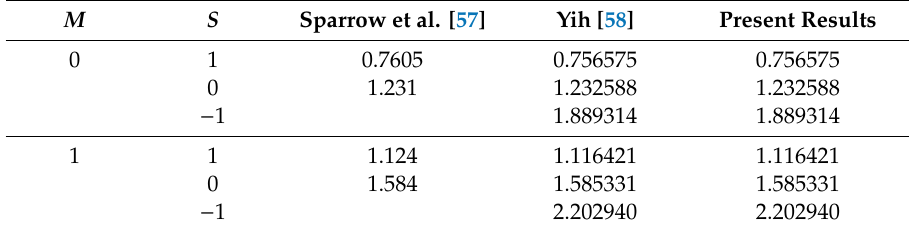
Table 3. Values of the skin friction coe ffi cient f (cid:48)(cid:48) ( 0 ) under di ff erent values of the magnetic parameter M and the permeability parameter S for regular fluid ( ϕ 1 = ϕ 2 = 0) when b = 0.